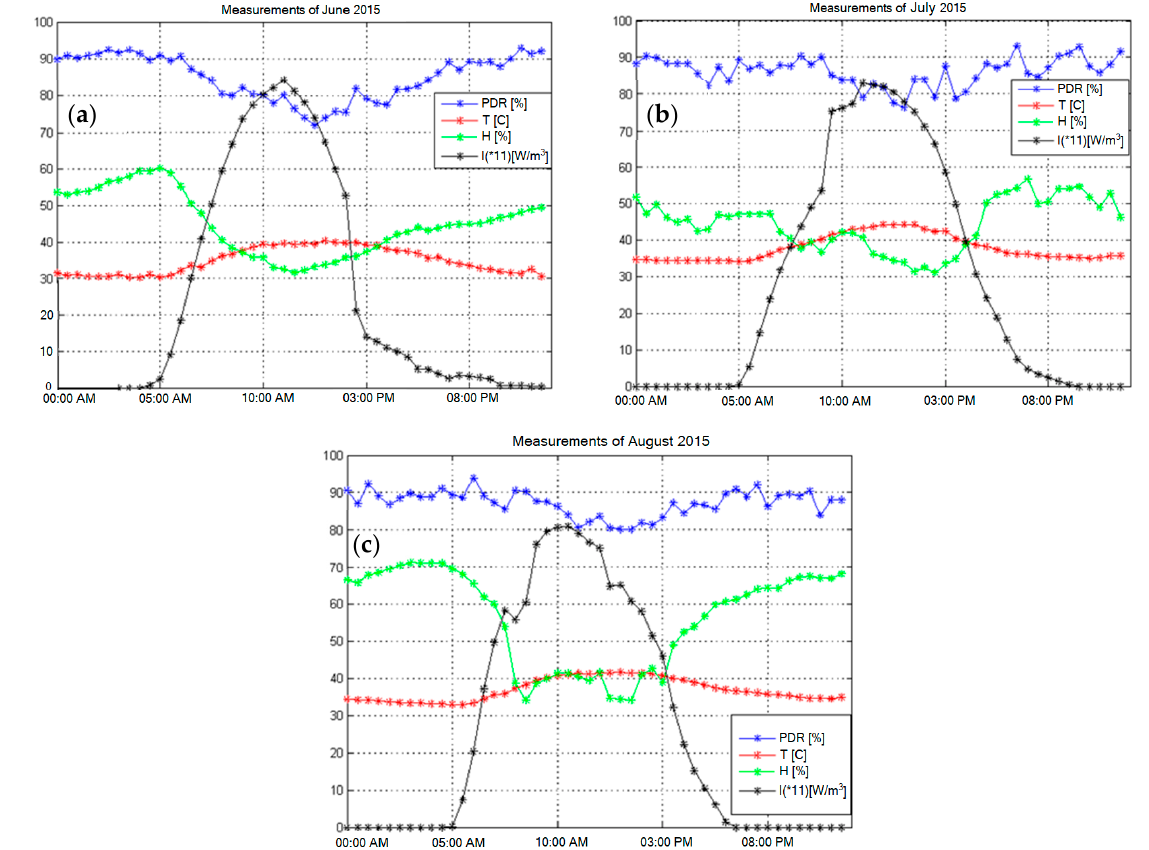
Figure 6. Behavior of FSO link vs weather factors during ( a ) June, ( b ) July, and ( c ) August 2015 (summer season). Table 3. Regression analysis output and t-test approach on the data for month of June.